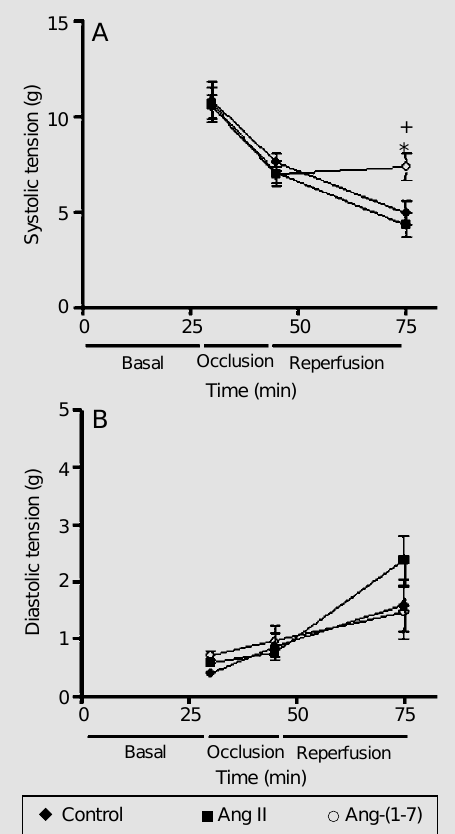
Figure 1. Time course of systolic (A) and diastolic tension (B) in isolated rat hearts. The hearts were perfused with Krebs- Ringer solution (KRS, control, N = 10), KRS containing 0.22 nM Ang-(1-7) (N = 10) or KRS con- taining 0.20 nM Ang II (N = 10) before and after (reperfusion) coronary occlusion. The maneu- vers are indicated on the ab- scissa. *P<0.05 compared to the control group and + P<0.05